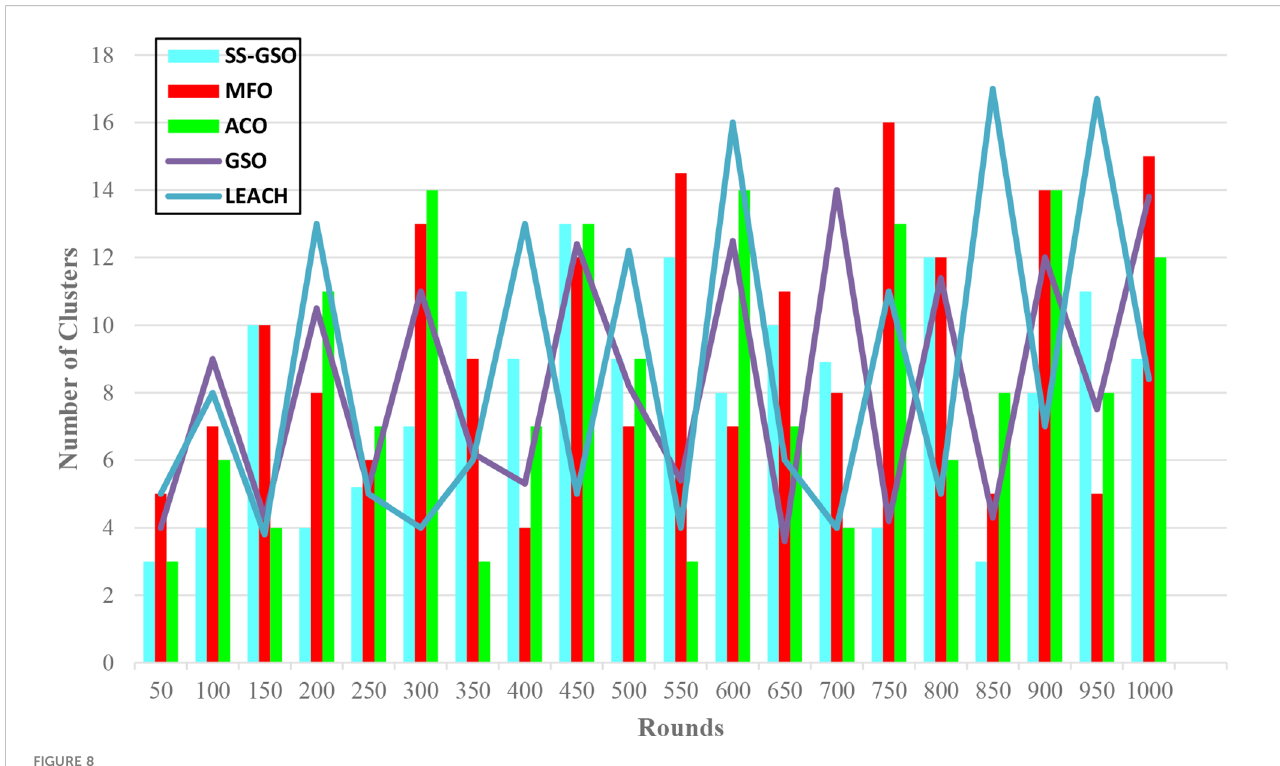
FIGURE 8 consistency of USWN cluster head cou.